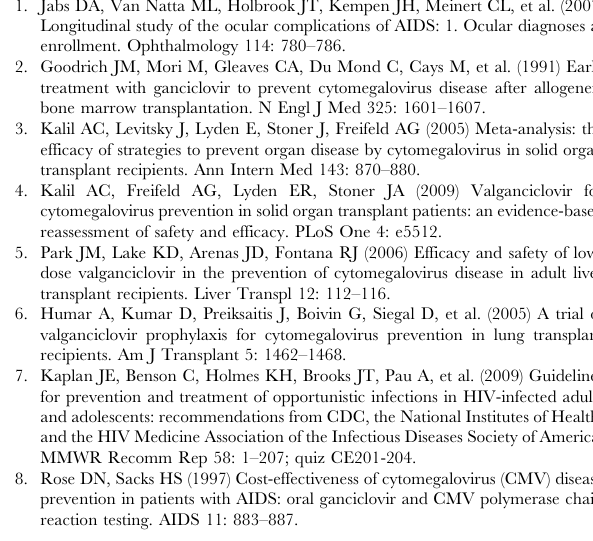
Table S1 Definitions of CMV end-organ diseases used in this study.